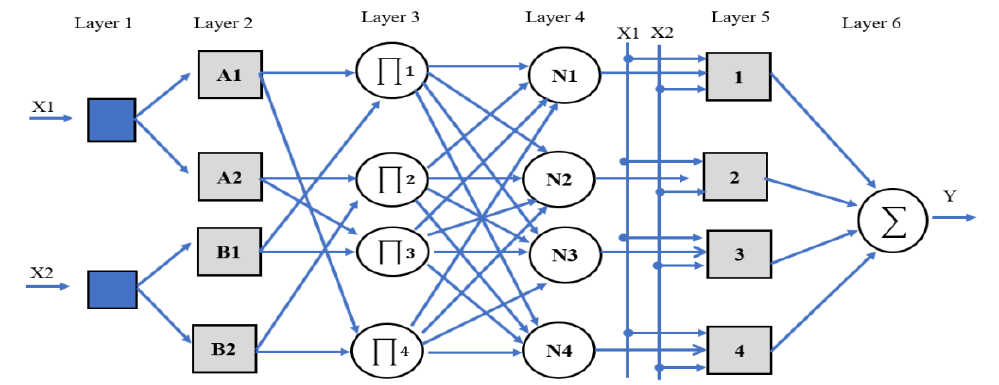
Figure 3. ANFIS architecture of a two-input model with four rules.